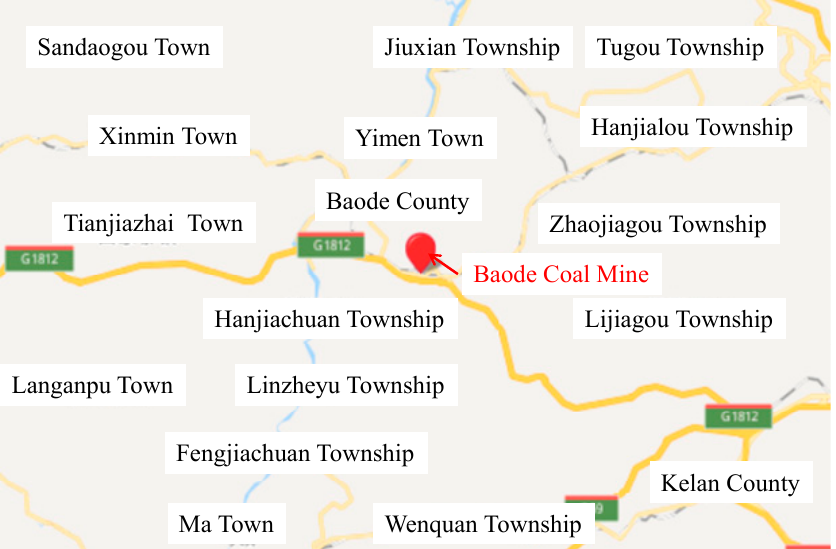
Figure 1. The location of the Baode coal mine.